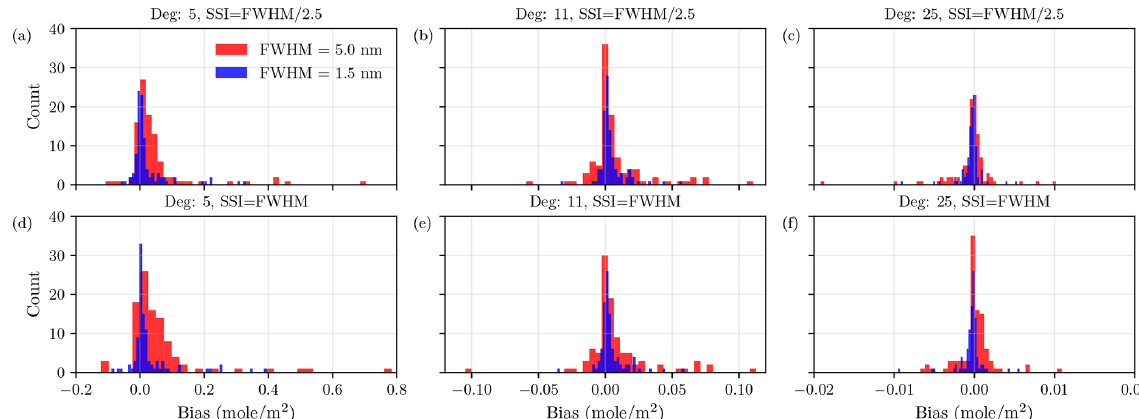
Figure 9. Plots showing a range of biases that occur over 100 randomly sampled surfaces when different FWHM, SSI, and polynomial degrees are used.